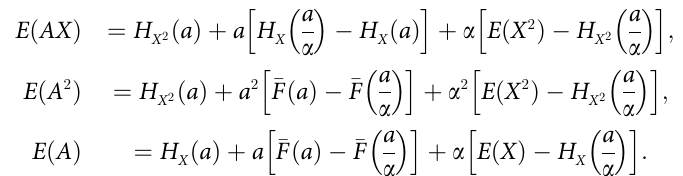
applied and the insured pays a percentage α of the claim amount. A and C are defined in Table 7.